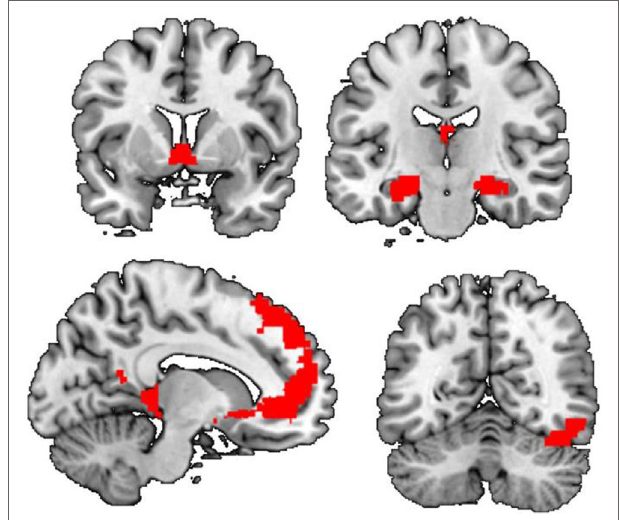
FigUre 1 | Main effect of cue reactivity. Compared to controls, cocaine users show enhanced cue reactivity within the dorsal and ventral anterior cingulate cortex, the bilateral ventral striatum, the left amygdala and right hippocampus/parahippocampal gyrus, and right occipital